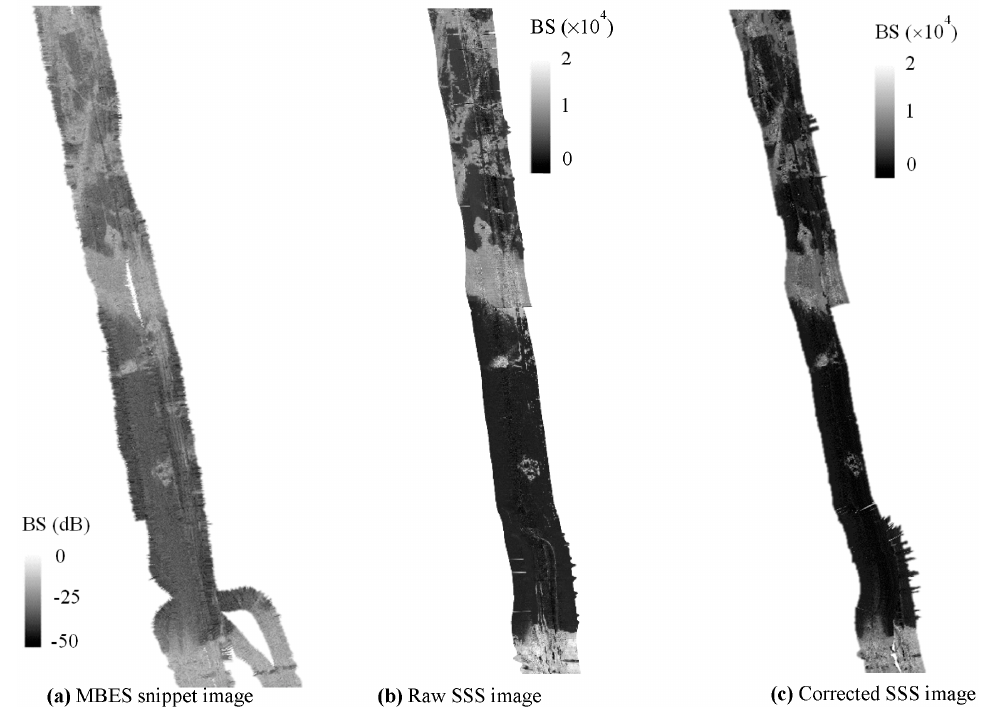
Figure 11. Matching of MBES and SSS images and the corrected position SSS image in entire waters. ( a ) MBES radiometric corrected images; ( b ) raw SSS image; and ( c ) corrected position SSS images. All ( a – c ) are in the same region as Figure 9b.